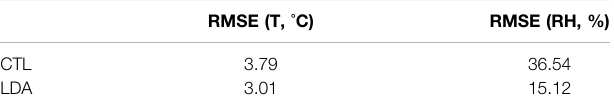
TABLE 2 | The root mean squared error (RMSE) of temperature and relative humidity in control experiment (CTL) and lightning data assimilation experiment (LDA).